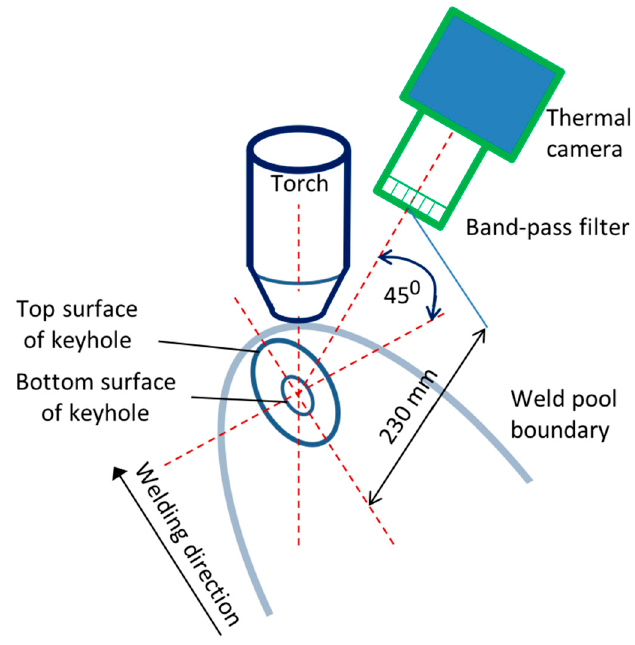
Figure 5. Schematic illustration of temperature measurement on the surface along the keyhole wall.